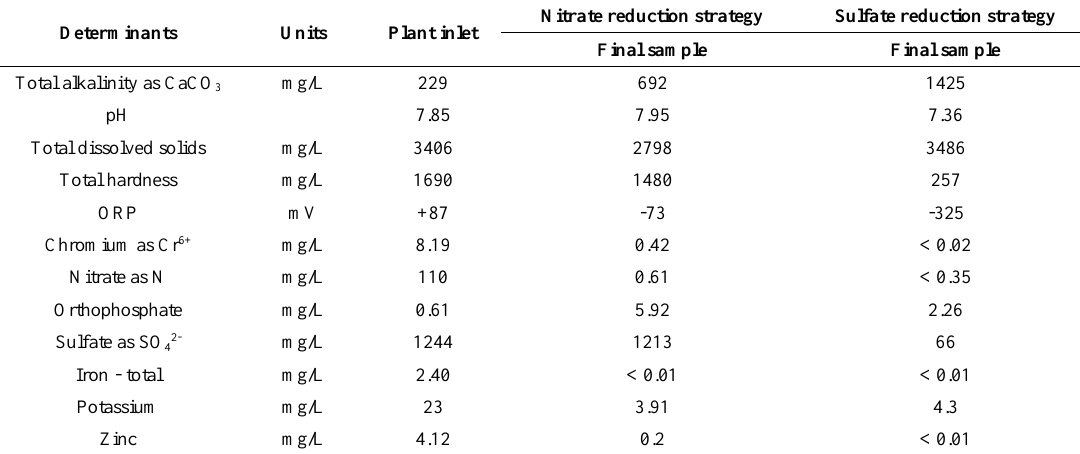
Table 4. Hydrochemical dataset of inorganic parameters during a pump-and-treat plant on site B. The data represents